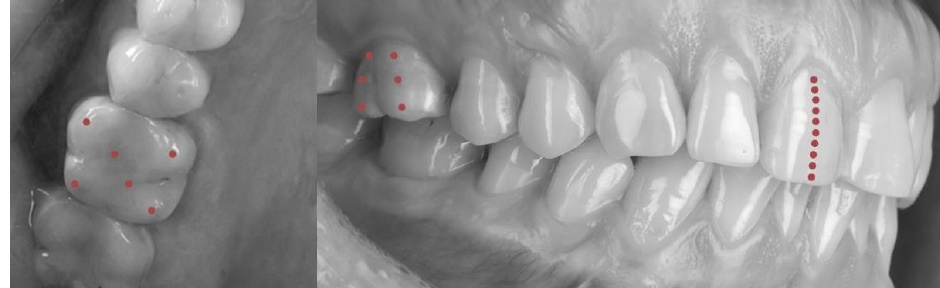
Figure 3. Measurement points for the evaluation of mouthguard thickness.